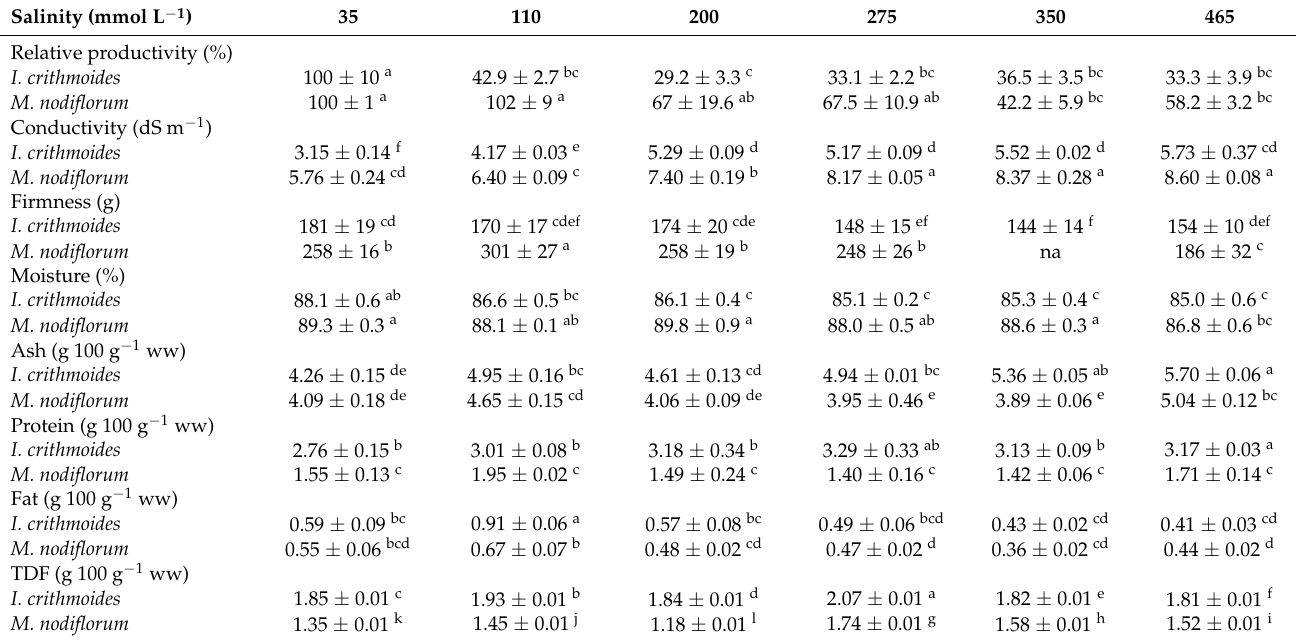
Figure 1. M. nodiflorum cultivated with the 35 mmol L − 1 ( a ) and 465 mmol L − 1 ( b ) nutrient solutions. The accumulation of reddish pigments in the stems becomes evident as the salinity is increased. Table 1. Relative productivity, electric conductivity, texture, and proximate composition of the samples cultivated at six different salinities. Values are presented as means ± SEM.